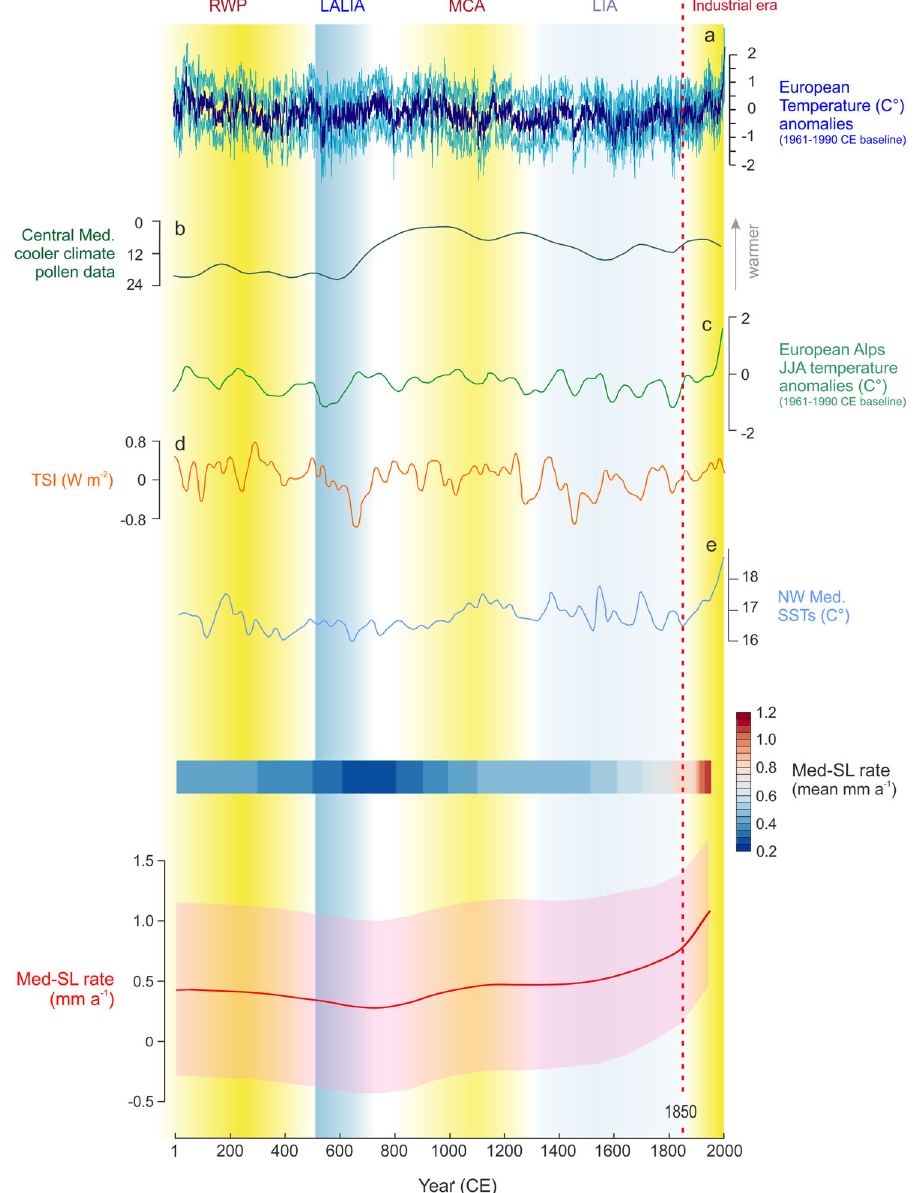
Fig. 4 Reconstructed variability of common sea-level signal (Med-SL) for the central and western Mediterranean region in the Common Era. Solid line and shaded envelope are the model mean and 1 s uncertainty. Med-SL is compared with a European Temperature anomalies 37 , b central Mediterranean cooler climate pollen data 38 , c summer (JJA) temperature anomalies in the European Alps 36 , d total solar irradiance 41 , e sea-surface temperatures (SSTs) in the western Mediterranean 40 . Temporal extension of the Roman Warm Period (RWP), the Late Antique Little Ice Age (LALIA), the Medieval Climate Anomaly (MCA), the Little Ice Age (LIA), and the Industrial period are from refs. 35,36 . The graded bar is the Med-SL model